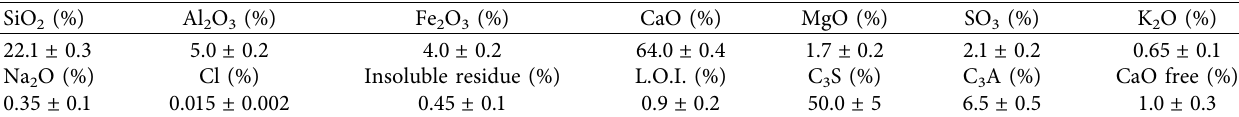
Table 2: Chemical characteristics of type 2 Portland cement.